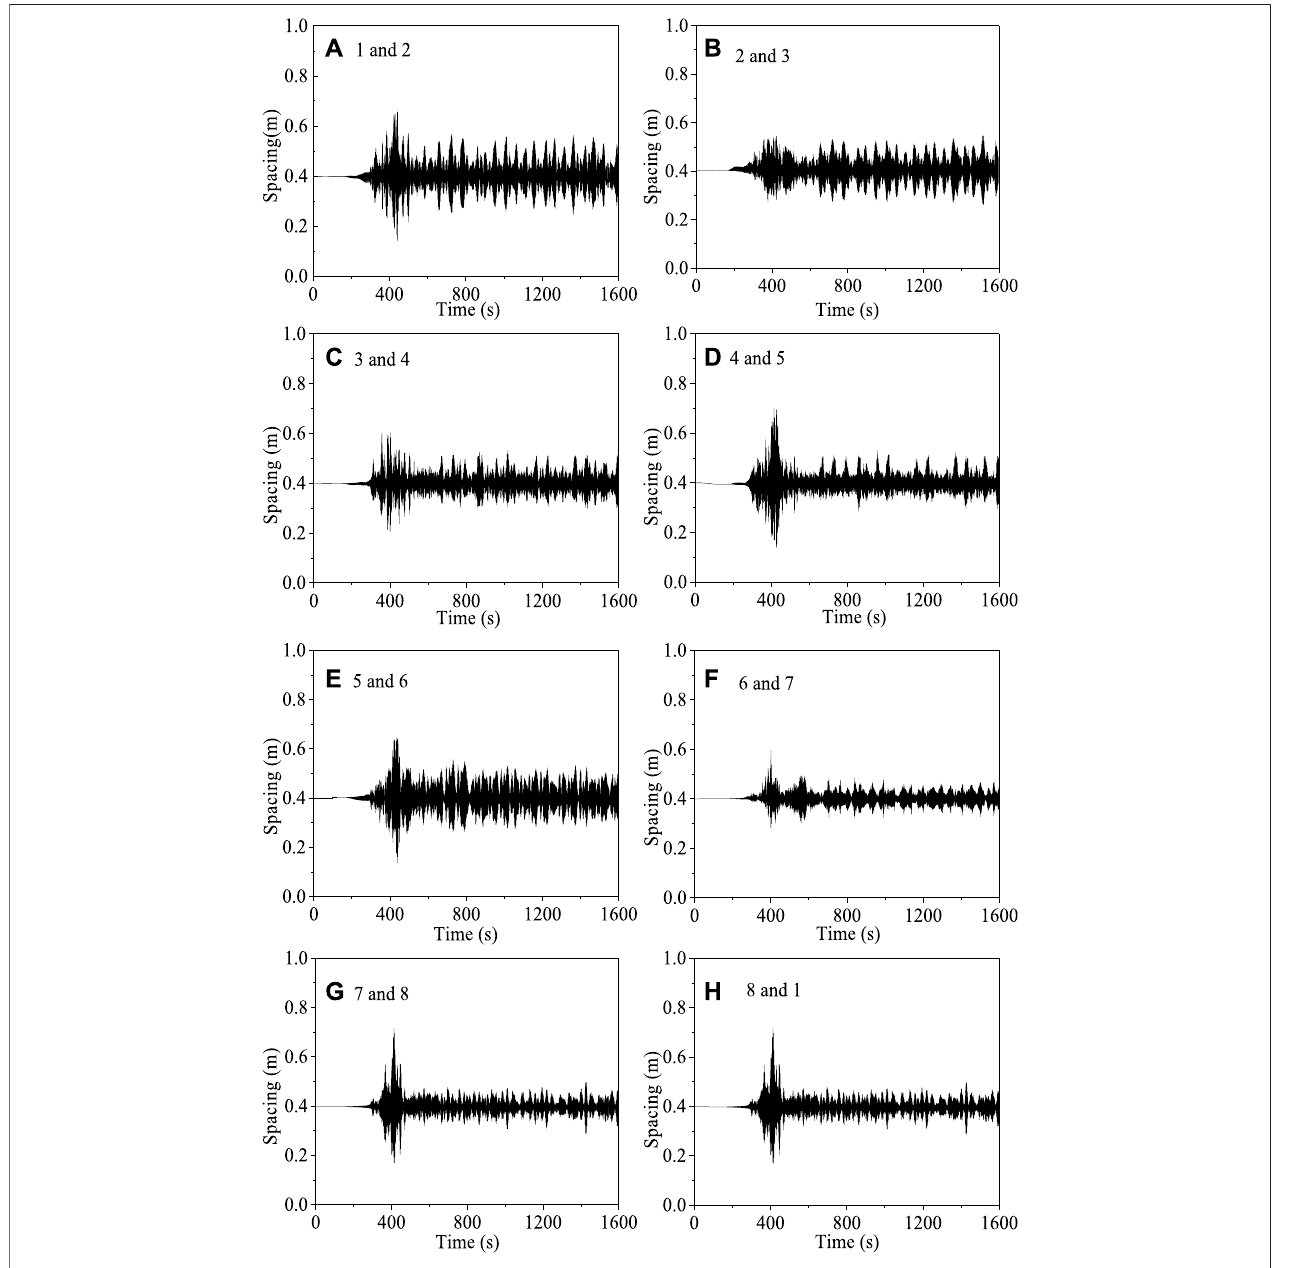
FIGURE 5 | Variation of the galloping distance of the respective conductors at the midpoint varying with time when the wind velocity is 12 m/s.